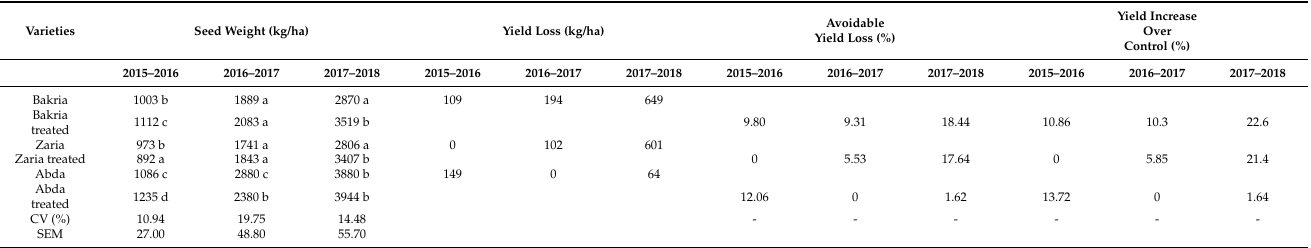
Table 3. Effect of aphid infestation on yield, avoidable yield loss, and yield increase due to aphid protection on different varieties at Marchouch station during three cropping seasons: 2015–2016, 2016–2017, and 2017–2018.